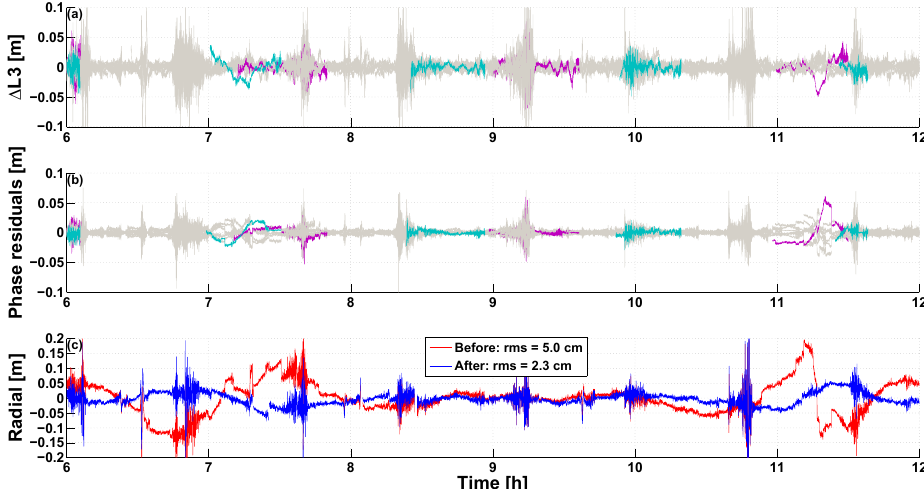
Figure 9. Outlier detection and anomalous GPS satellite for Swarm A on DoY 271, 2015, here PRN26 (purple) and PRN32 (green); (a) (cid:49)L 3 between epochs separated by 100s, (b) phase residuals and (c) deviations of the kinematic orbit with respect to ESA reduced-dynamic orbits with (red) or without (blue) the anomalous GPS satellites.